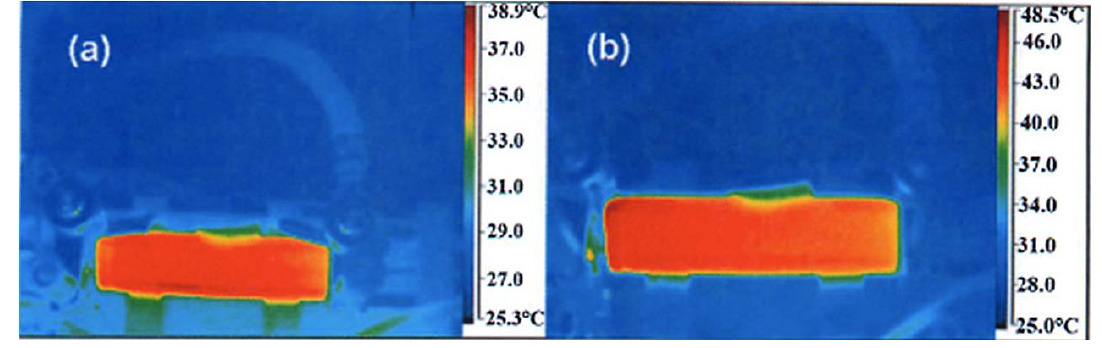
Figure 12. Thermal infrared image of the LTO//LFP “18650”-type cell recorded during charge at rate 50C, at full charge 2.1 V (bottom), and total discharge at 1.0 V (top). The electrolyte is with 1 mol L − 1 LiPF in EC-DEC (1:1). (Reprinted with permission 6 from [68]. Copyright 2011